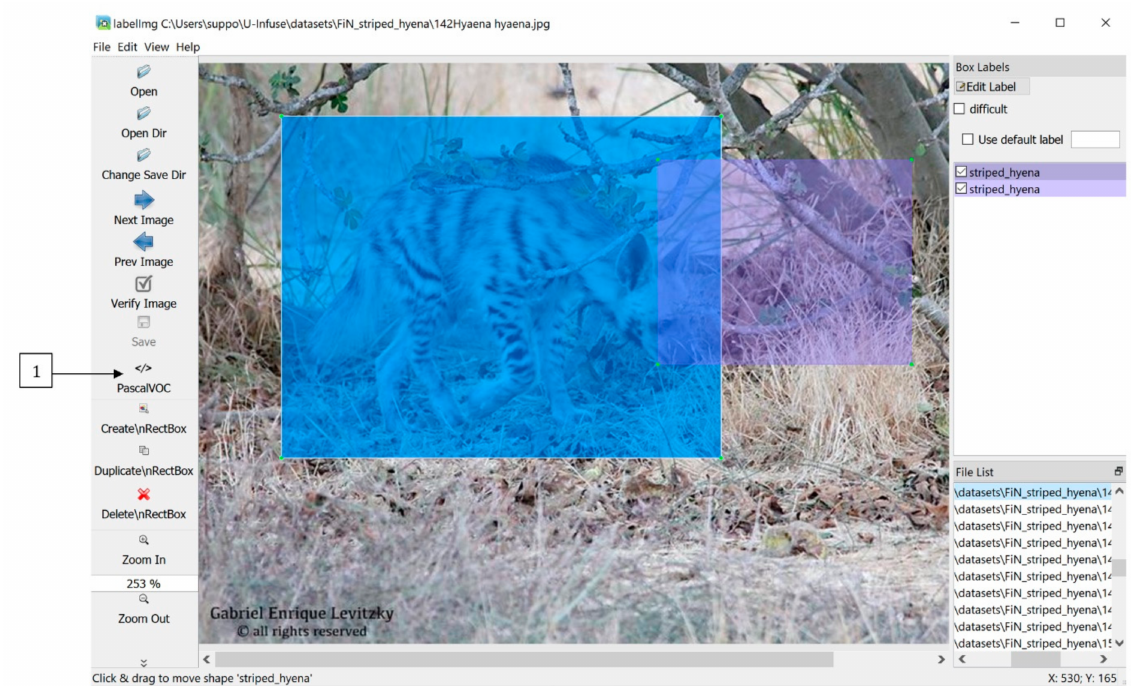
Figure 10. Annotations can be edited in labelImg. Bounding boxes can be added, removed or altered. Labels can also be